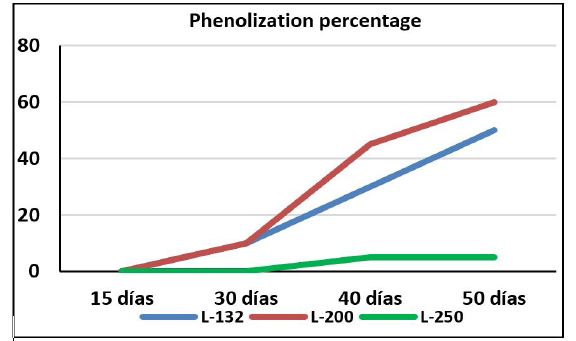
Figure 7. Process of phenolization of thorny artichoke microplants ( Cynara scolymus L.) of three clonal lines during ex vitro rooting in